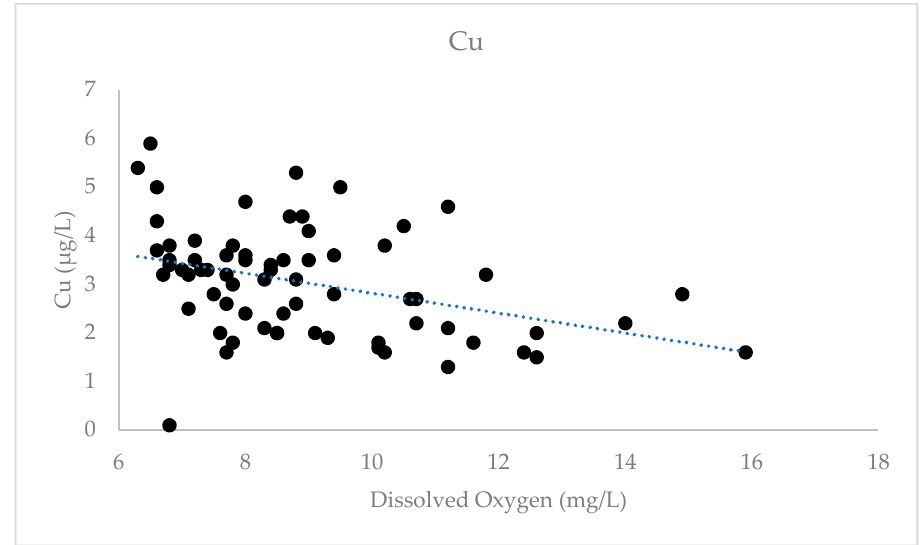
Figure 2. Relationship between copper and dissolved oxygen at the Rock Creek watershed (R 2 = 0.14).